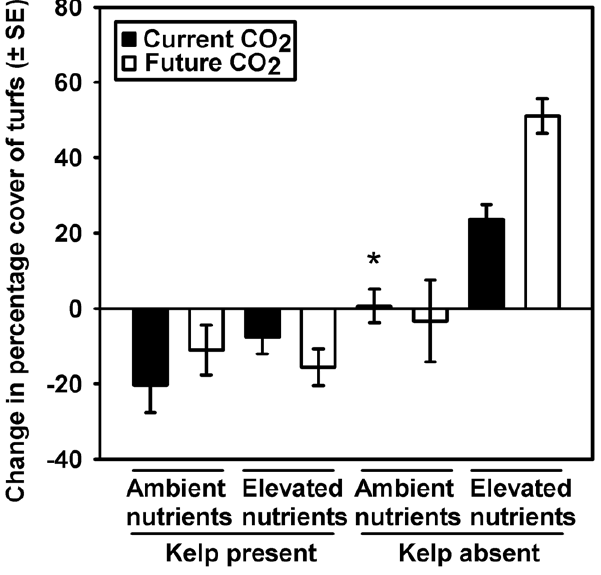
Figure 1. The change in percentage cover of turf-forming algae (final – initial measurement) that were transplanted from ambient conditions* to different combinations of Kelp (pres- ent v. absent), Nutrients (ambient v. elevated) and CO 2 (current v. future). * Ambient conditions=turfs growing in canopy gaps under ambient concentrations of nutrients and CO 2 .